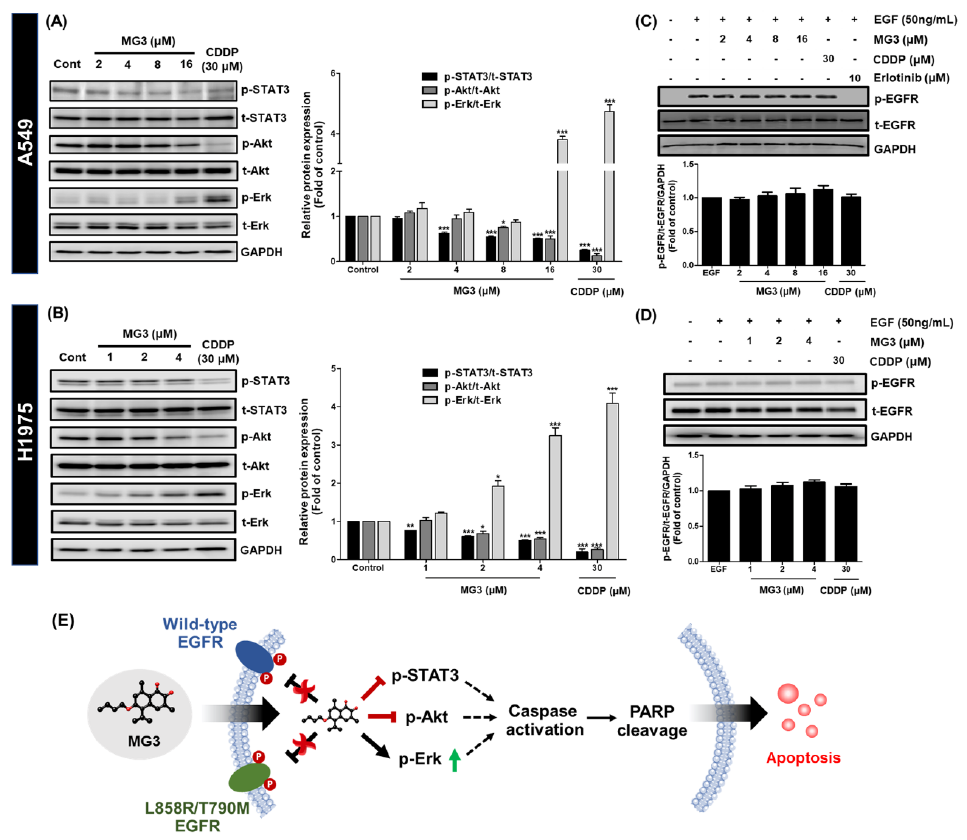
Figure 4. MG3 dose-dependently inhibits the phosphorylation of STAT3 (Tyr705) and Akt (Ser473) in ( A ) A549 and ( B ) H1975 cells at 24 h. The expression of p-Erk (Thr202/Tyr204) is found to be increased upon MG3 and CDDP treatments. The phosphorylation of EGFR (Y1068) for both ( C ) A549 and ( D ) H1975 cells is not significantly affected by MG3 and CDDP treatments. ( E ) Proposed mechanisms of MG3 against two studied NSCLC cell lines, in which MG3 promotes cell apoptosis through the inhibition of p-Akt and p-STAT3 as well as through the activation of MAPK signaling pathway. Data are expressed as mean ± SEM of three independent experiments. * p ≤ 0.05, ** p ≤ 0.01, and *** p ≤ 0.001 vs.